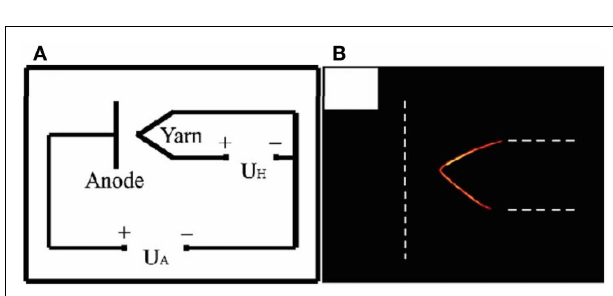
FIGURE 11 | (A) Electrical circuit of thermionic energy converter with CNT yarn. (B) Optical image of CNT yarn heated to 1333K by a DC current. Reprinted with permission from Liu et al.